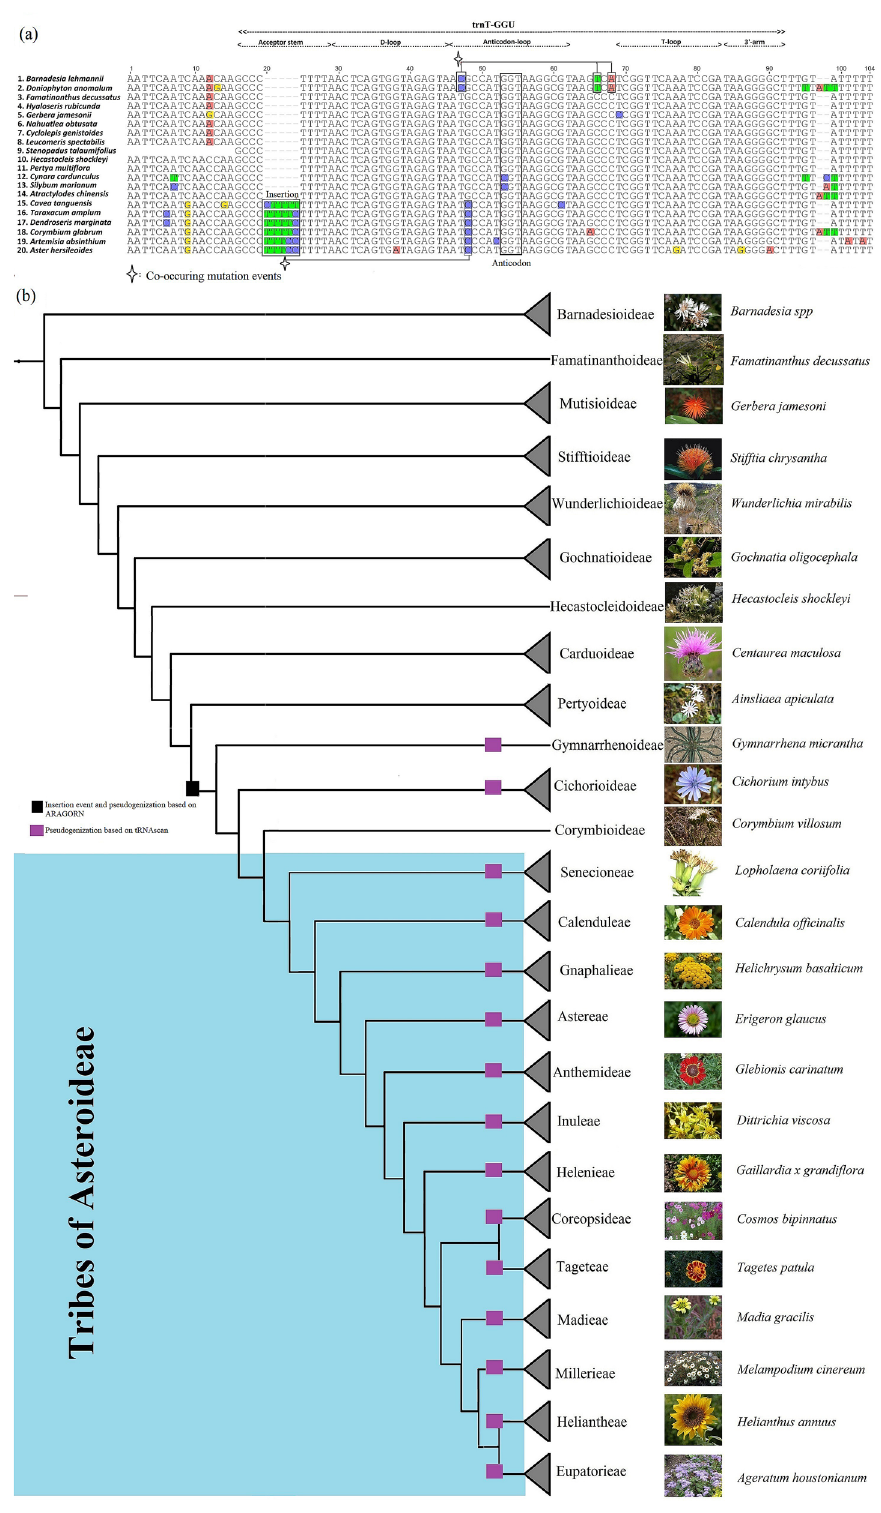
Figure 1. Multiple sequence alignment of the plastid threonine ( trn T-GGU) gene and the position of pseudogenes within the phylogenetic tree. ( a ) All functional parts of the gene have been noted above the alignment. The insertion occurring in the acceptor stem is highlighted. Co-occurrence of mutational events in some species are shown above and below the alignment. (b) The black block indicates the starting node of the insertion event in the 5 ′ acceptor stem and pseudogene detected by ARAGORN among species of the ‘Core Asteraceae’ clade, whereas the purple block indicates the presence of pseudogenes based on tRNAscan-SE. Leaves of the phylogenetic tree from Barnadesioideae to Corymbioideae represent subfamilies of Asteraceae, while all other leaves of phylogenetic trees represent 13 tribes of the Asteroideae subfamily (indicated in blue background), followed by the icon size photo of a representative species used in our analysis. The species from 13 tribes of Asteroideae were included in the analysis and their names are noted at each node in the highlighted background. The representative photos of each subfamily and tribe are included in the figure and the species names are provided in front of each